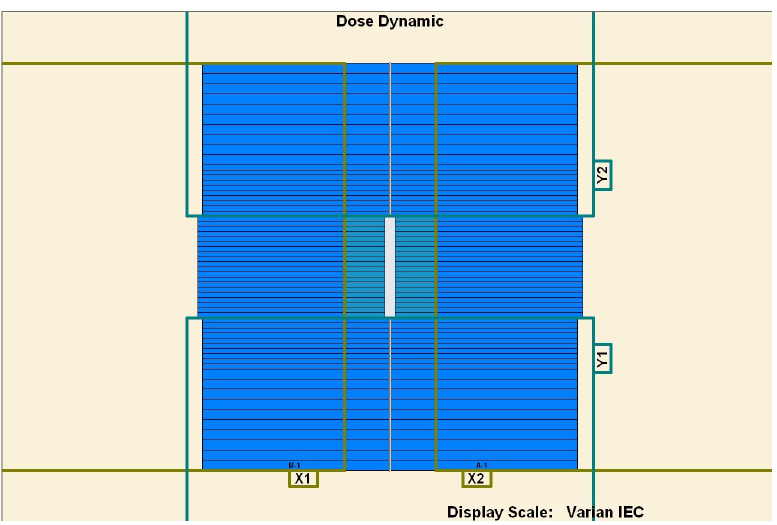
Fig 3. Five segments designed to be 1 × 10 cm 2 . (1) First segment’s center: − 4 cm. (2) Second segment’s center: − 2 cm. (3) Third segment’s center: 0 cm. (4) Fourth segment’s center: 2 cm. (5) Fifth segment’s center: 4 cm.